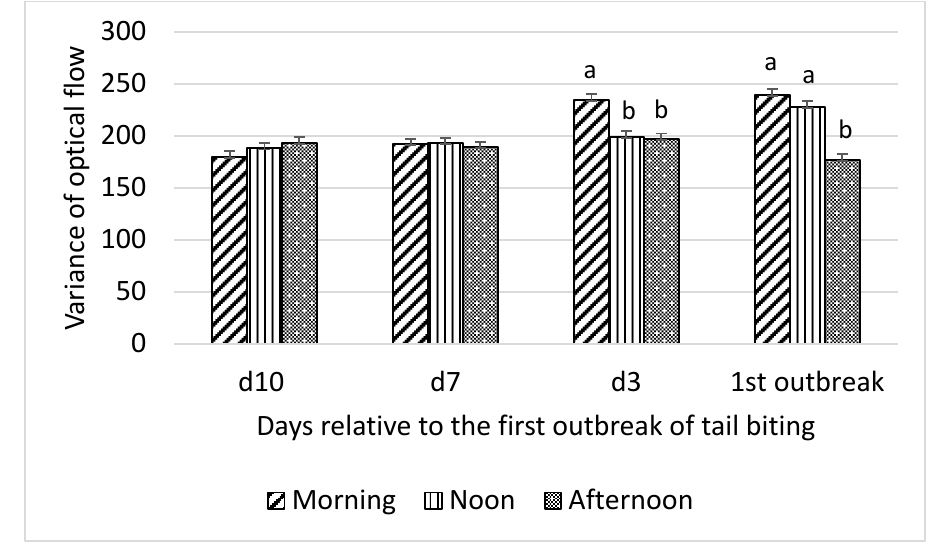
Figure 2. Interaction between day (10 d, 7 d, and 3 d before and during) relative to the first outbreak of tail biting and time of day (morning, noon, and afternoon) for variance of optical flow; ab —within days means without a common superscript differ ( p < 0.01).